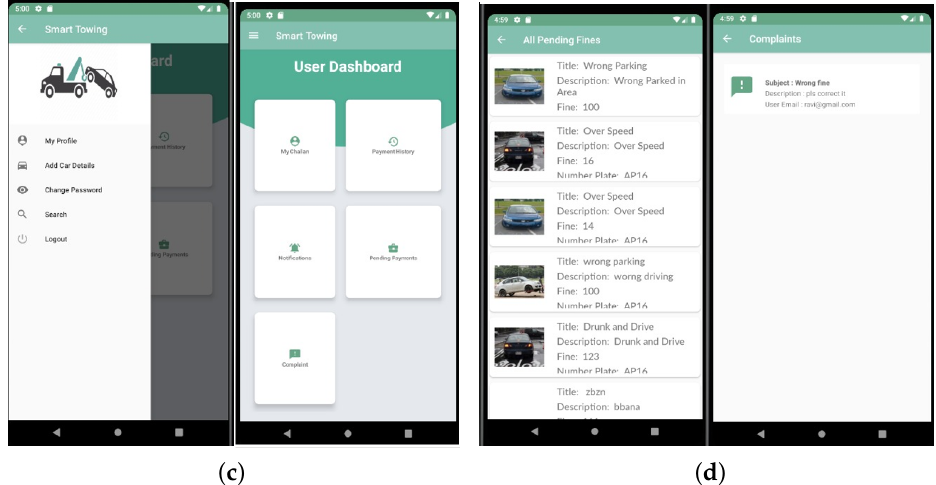
Figure 5. Screenshots of the mobile app for the car towing management system. ( a ) Landing and login screens. ( b ) User registration and admin dashboard screens. ( c ) User menu and dashboard. ( d ) Pending fines and user